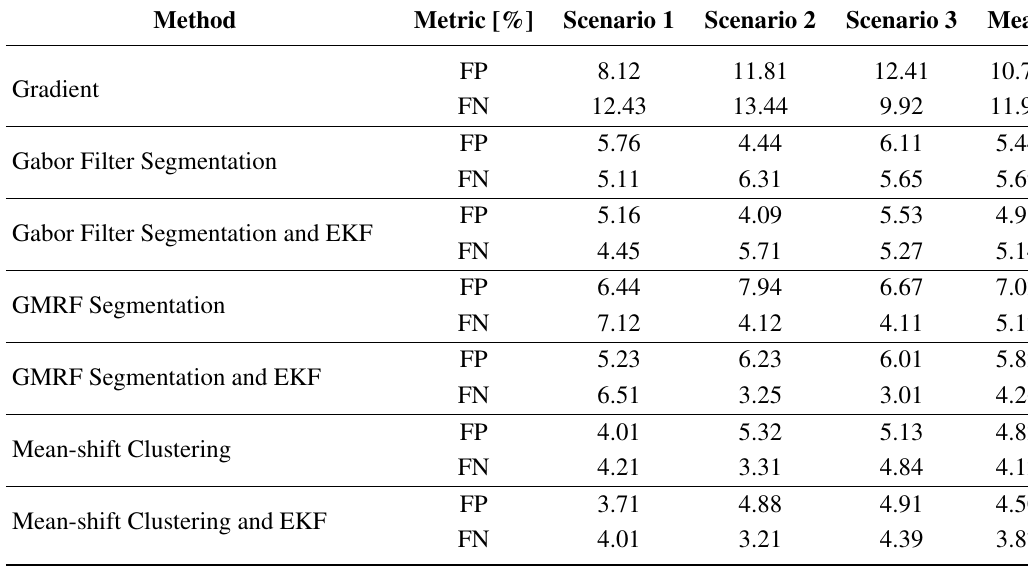
Table 4. Lane departure warning